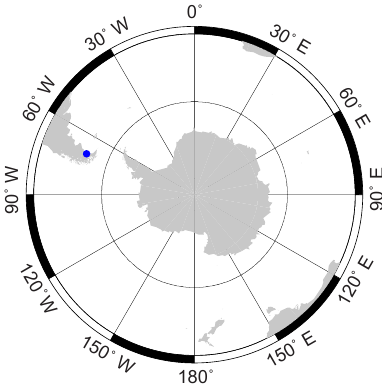
Figure 1. Location of the OAPA site in Río Gallegos, Argentina, (51.6 ◦ S, 69.3 ◦ W), shown as a blue circle. Latitude ranges from 30 to 90 ◦